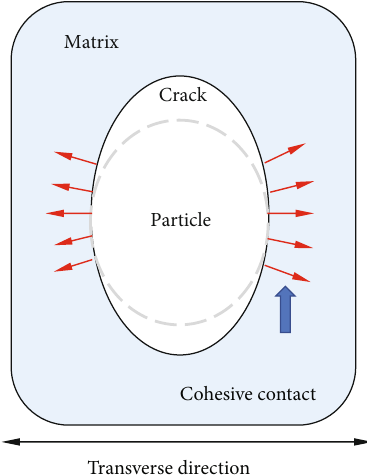
Figure 19: Schematic of the e ff ect of cohesive contact on the transverse